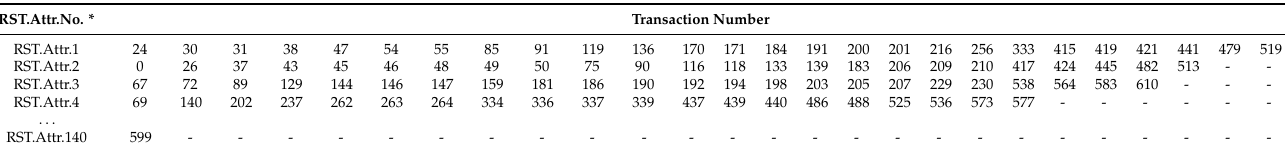
Table 3. Example of RST.Attr. groupings of homogeneous property attributes sets within a selected homogeneous area. Source: own elaboration.